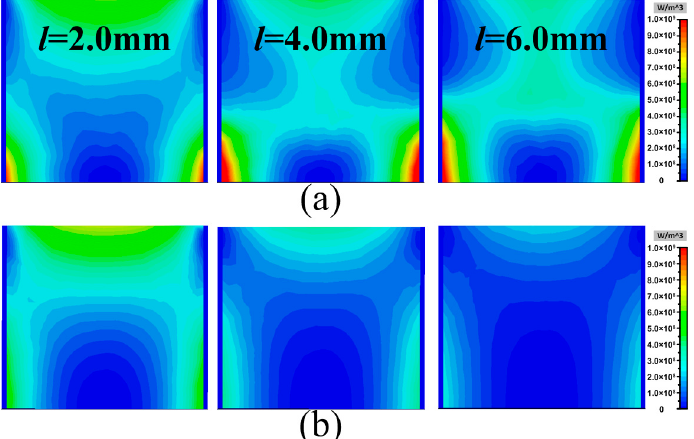
Figure 7. ( a ) Energy loss distributions of the proposed MAs with different widths of metallic bamboo joints ( l = 2.0, 4.0 and 6.0 mm) at the frequencies of the lower-frequency absorption peaks ( f = 4.4, 3.3, and 2.5 GHz, respectively); and ( b ) energy loss distributions of the three-dimensional resistive MA at corresponding frequencies.